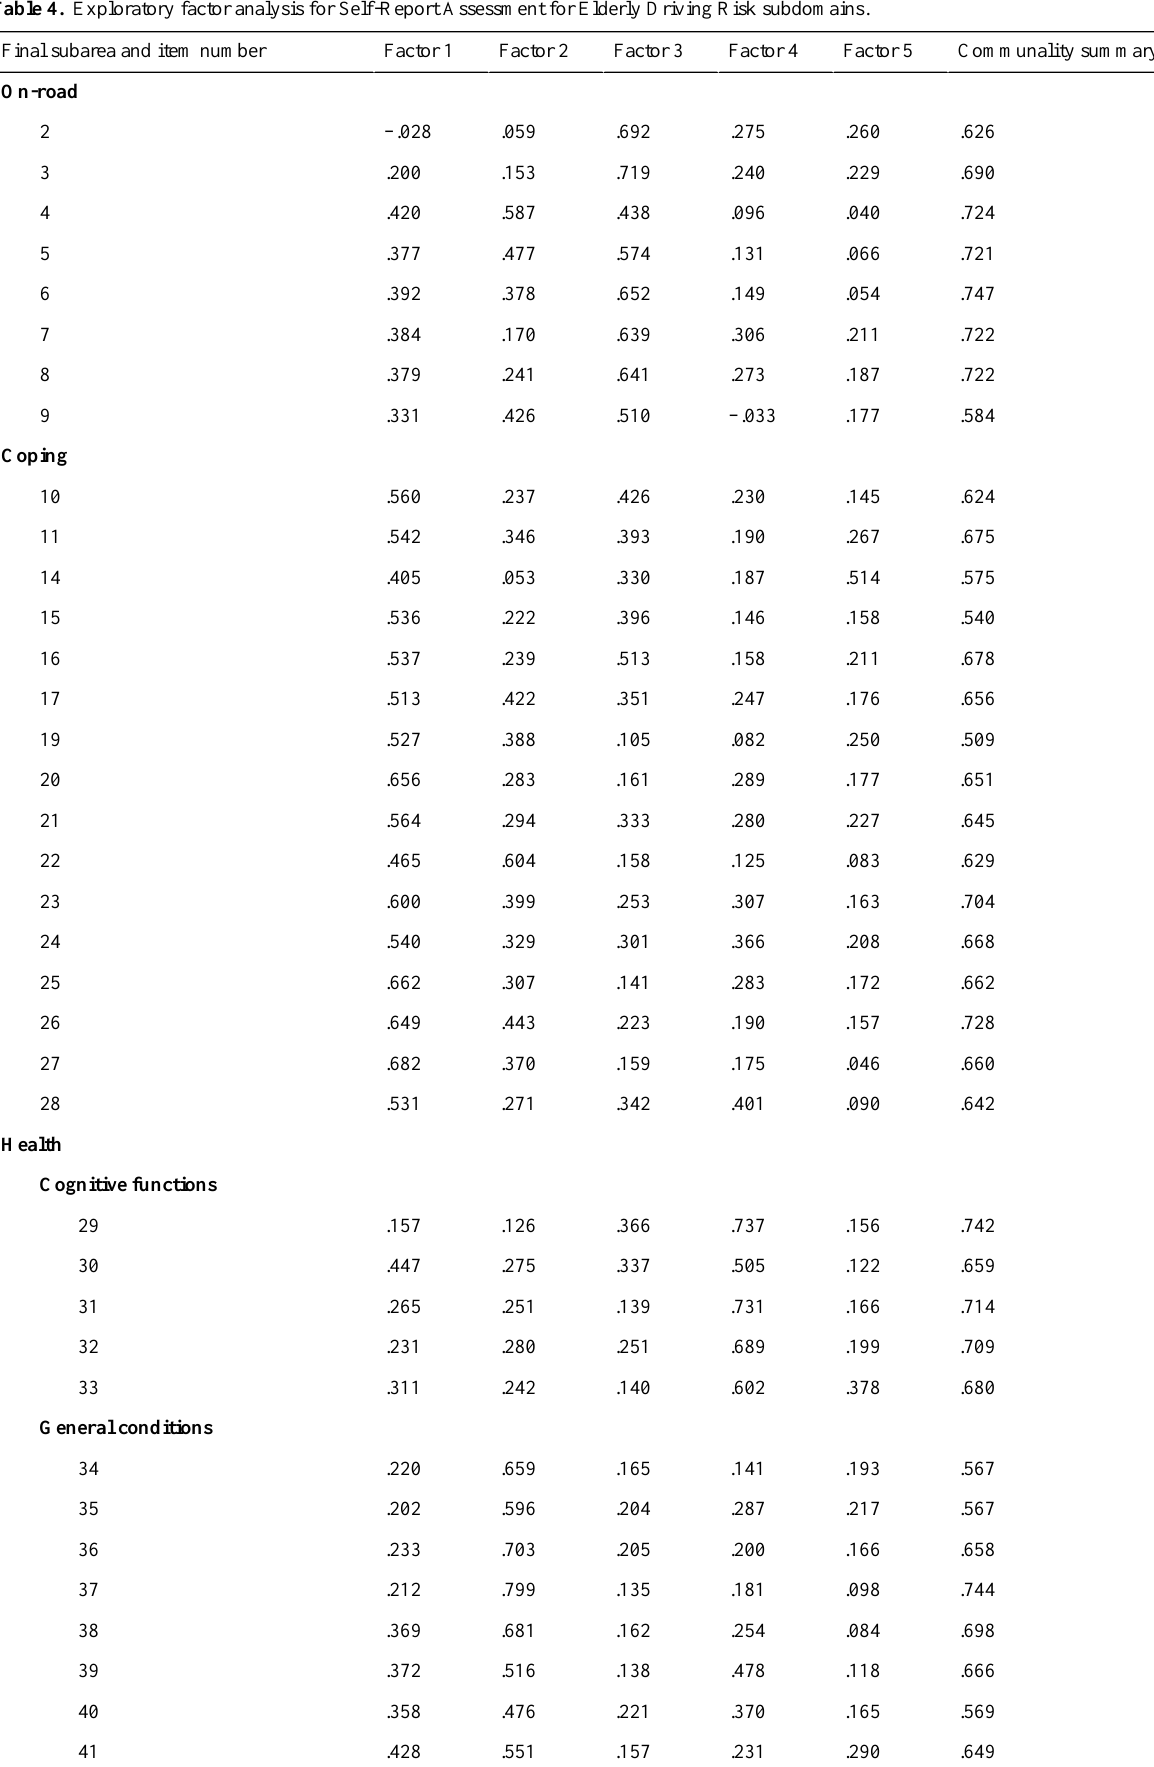
Table 4. Exploratory factor analysis for Self-Report Assessment for Elderly Driving Risk